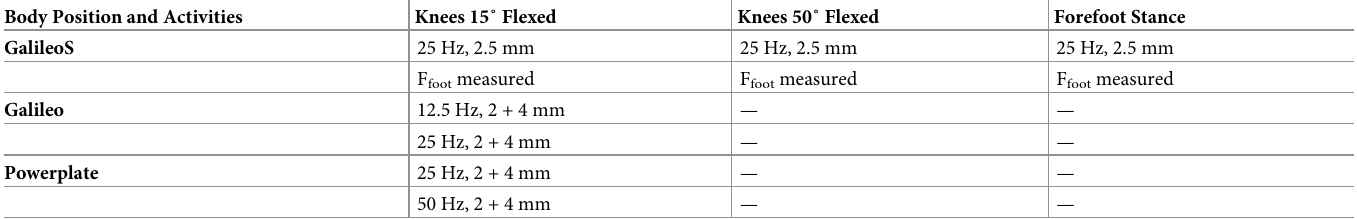
Table 2. Measurement conditions. The vibration strokes s = 2 to 4 mm are peak-to-peak values. The force F foot between platform and foot was only measured on the GalileoS. Walking at 4 km/h and stance without vibrations in the three positions were additionally